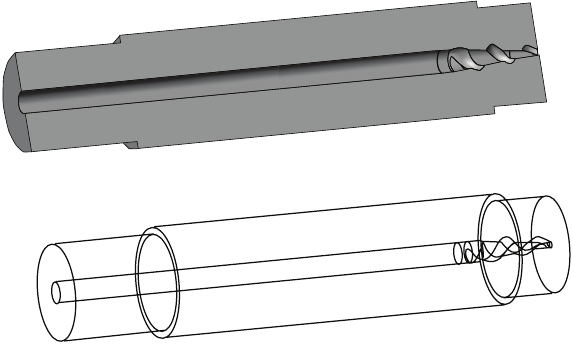
Figure 6: 3D structure of helix